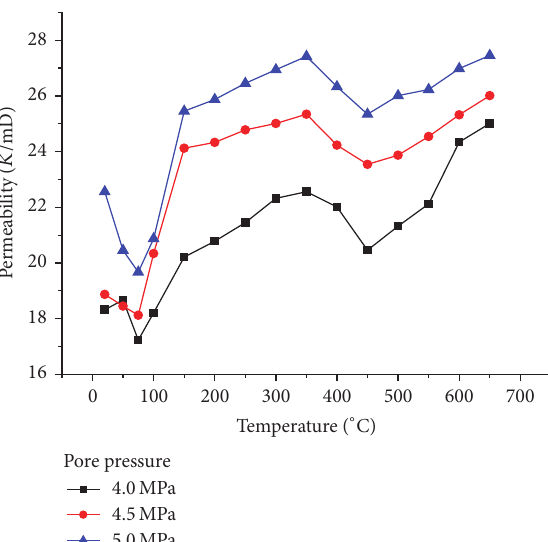
Figure 13: Variations of permeability with temperature